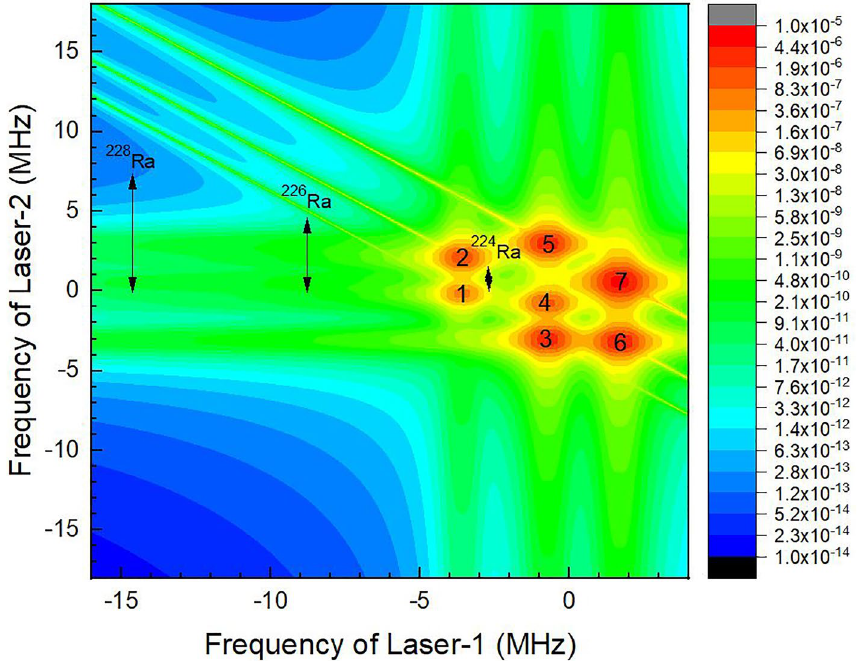
Figure 2. Two dimensional contour of the ionization efficiency of 223 Ra isotope under Doppler free